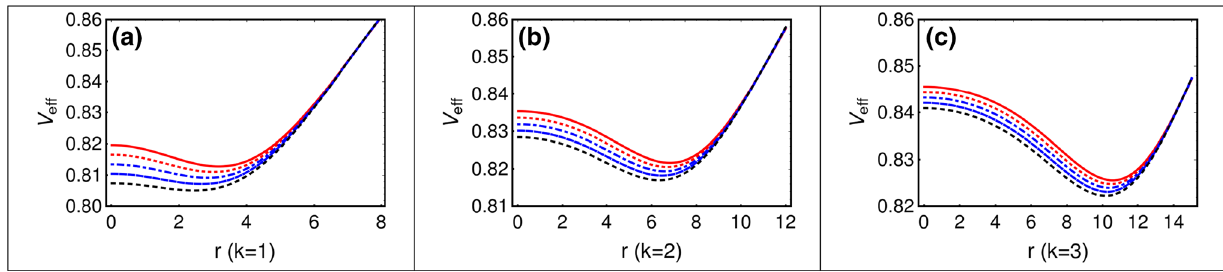
Fig. 3 The effective potentials of the spinning test particle with ¯ j + ¯ s = 0. From top line to bottom line, the corresponding spin and orbital angular momenta are taken as ( ¯ s , ¯ j ) = ( − 0 . 5 , 0 . 5 ) , ( − 0 . 25 , 0 . 25 ) , ( 0 , 0 ) , ( 0 . 25 , − 0 . 25 ) , ( 0 . 5 , − 0 . 5 )